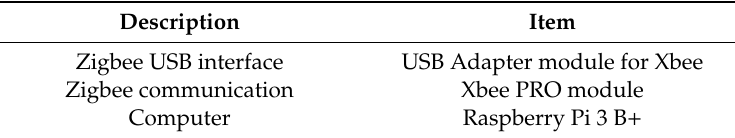
Table 3. On-the-ground test